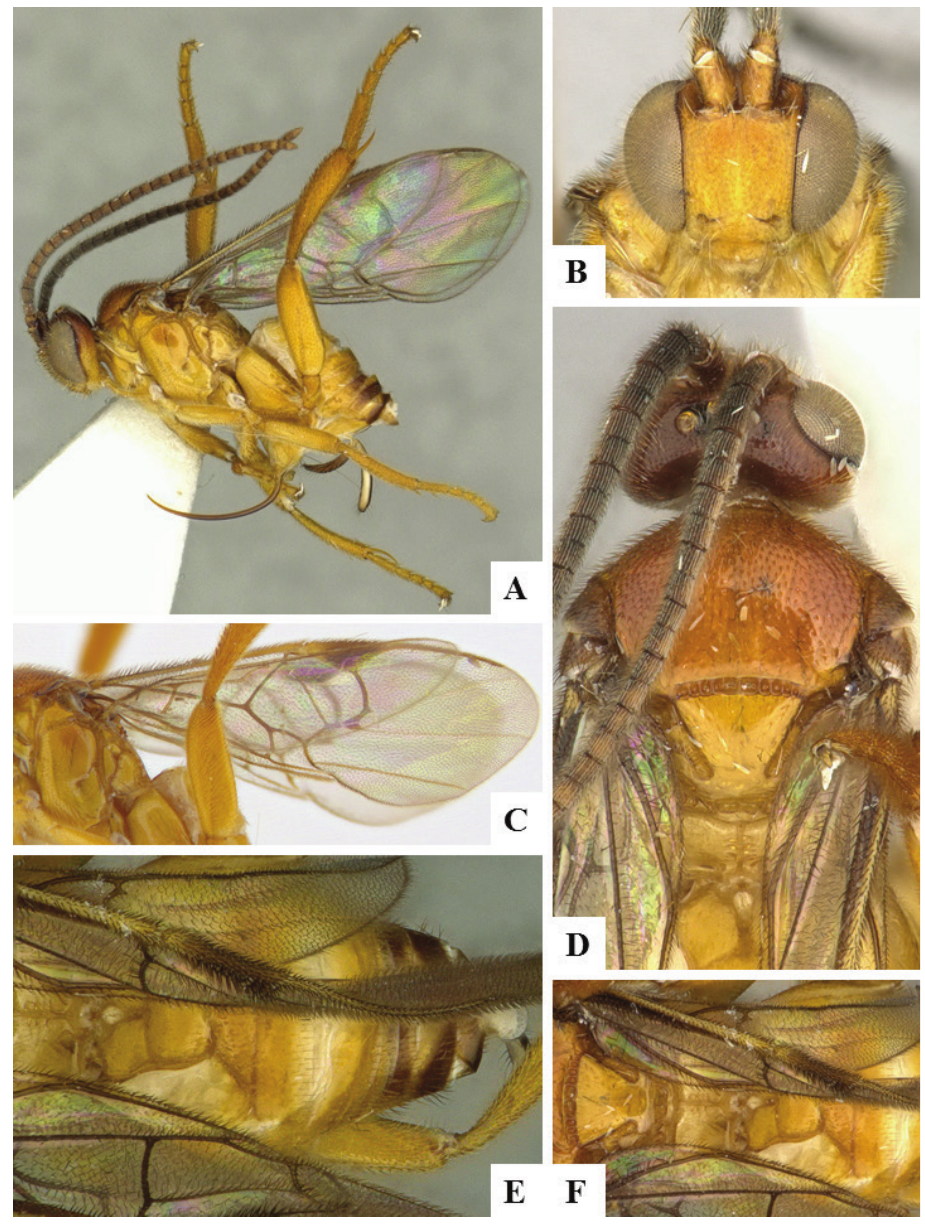
Figure 41. Ypsilonigaster naturalis female holotype. A Habitus B Head frontal C Fore wing D Head and mesosoma, dorsal E Metasoma dorsal F